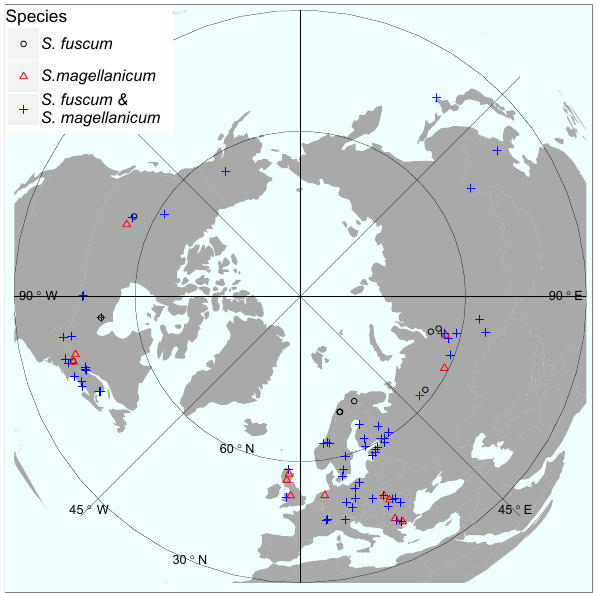
Figure 1. Map illustrating sample sites for the investigated species. At some sites only one of the two Sphagnum species was sampled, indicated by red triangles or black circles. Otherwise sites contained both species (blue crosses). The map is centred on the North Pole and has an orthographic projection. Geographical ranges: latitude 41.6–69.1N, elevation 2 – 1829ma.s.l. See Table S1 for